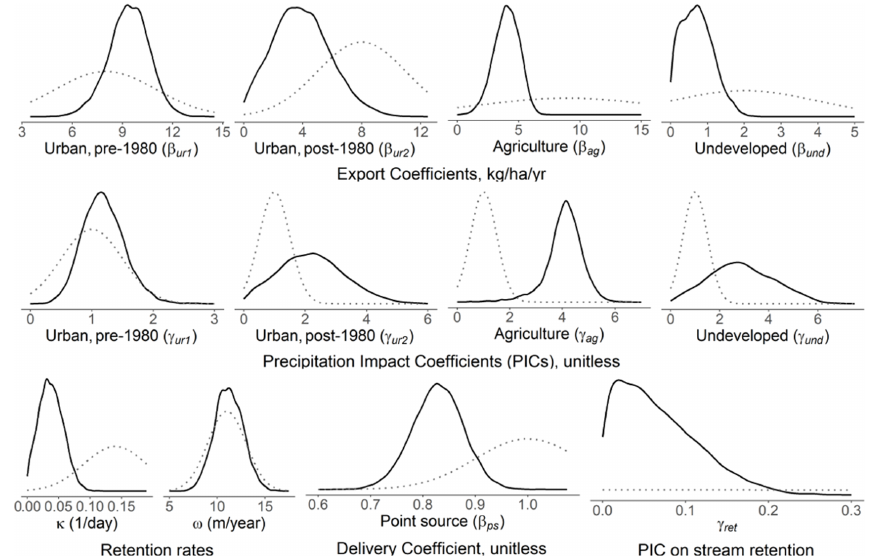
Figure 4. Prior (dotted lines) and posterior (solid lines) distributions for selected model parameters. Note that priors and posteriors are provided for all parameters in Tables 3 and S3.